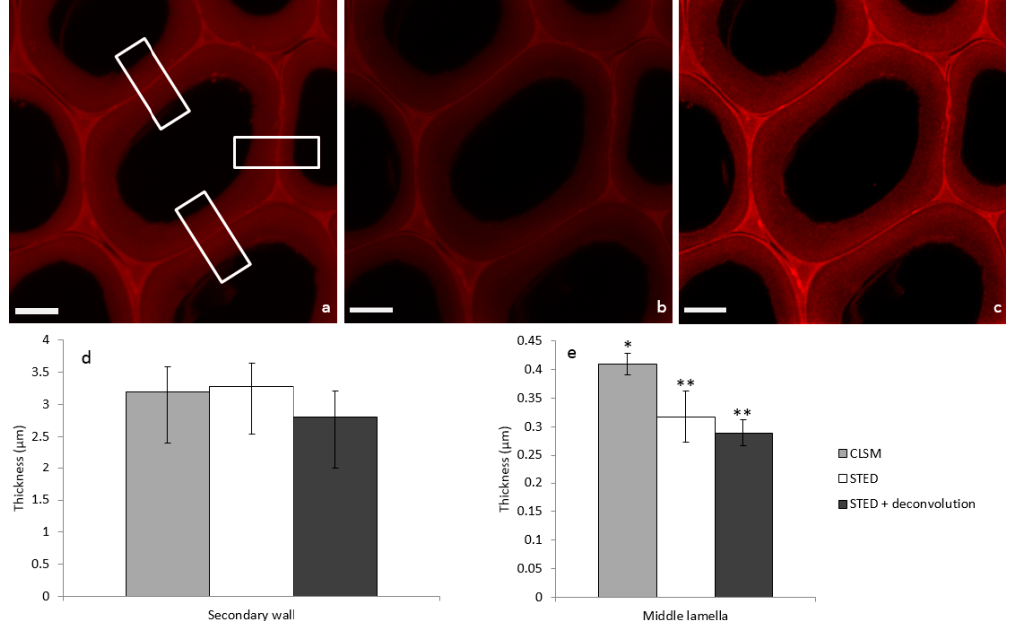
Figure 3. Images of poplar sections incubated with PEG-R and acquired in the same area by ( a ) CLSM, ( b ) STED, and ( c ) STED + deconvolution (scale bar: 5 µm). Corresponding mean thickness of ( d ) secondary cell wall and ( e ) middle lamella are extracted from Gaussian mean intensity (Supplementary File) profile in rectangle areas (means from n = 3, Mann-Whitney test indicates two separate groups marked by * and ** with a statistical difference p < 0.05).